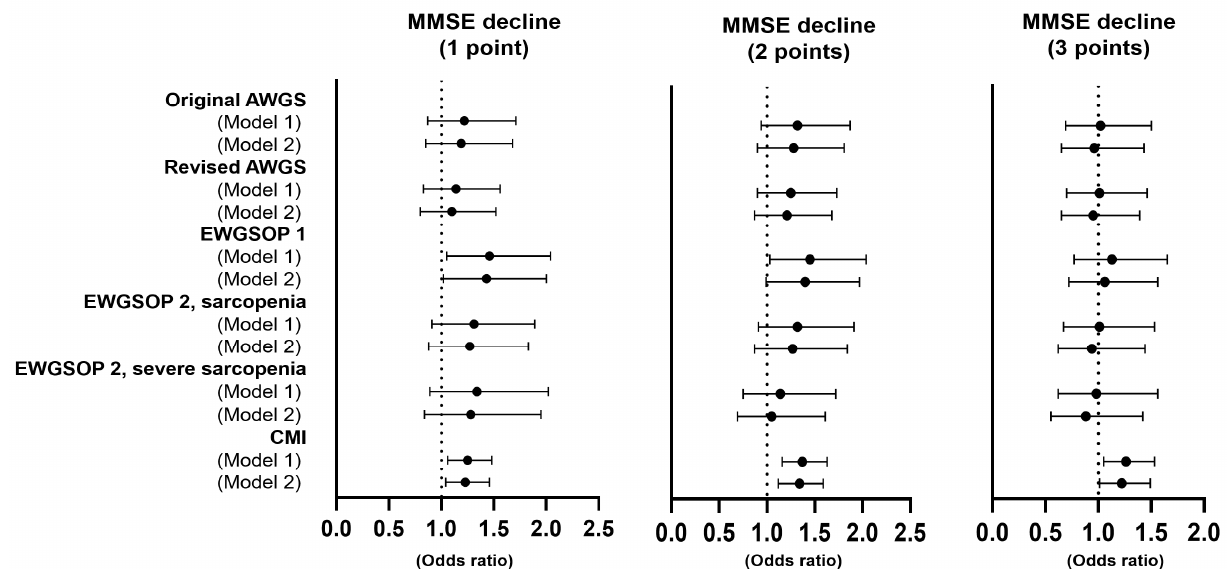
Figure 3. Longitudinal associations of sarcopenia with meaningful decline in the MMSE score. Model 1 adjusted for age, sex, and the baseline MMSE score; Model 2 was adjusted for age, sex, baseline MMSE score, multimorbidity, ADL disability, and IADL disability. MMSE, Mini-Mental Status Examination; AWGS, Asia Working Group Society; EWGSOP, European Working Group on Sarcopenia in Older People; CMI, Cumulative Muscle Index; CI, confidence interval.